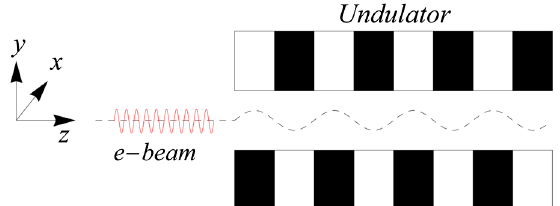
FIG. 1. Cartoon of a thin snake beam at the entrance to an undulator. The beam charge is localized in the horizontal plane on the line x ¼ a sin ð 2 (cid:2)z=(cid:1) 0 Þ . The broken line shows the trajectory of the beam. The relative length of the beam and the period of the undulator are not to